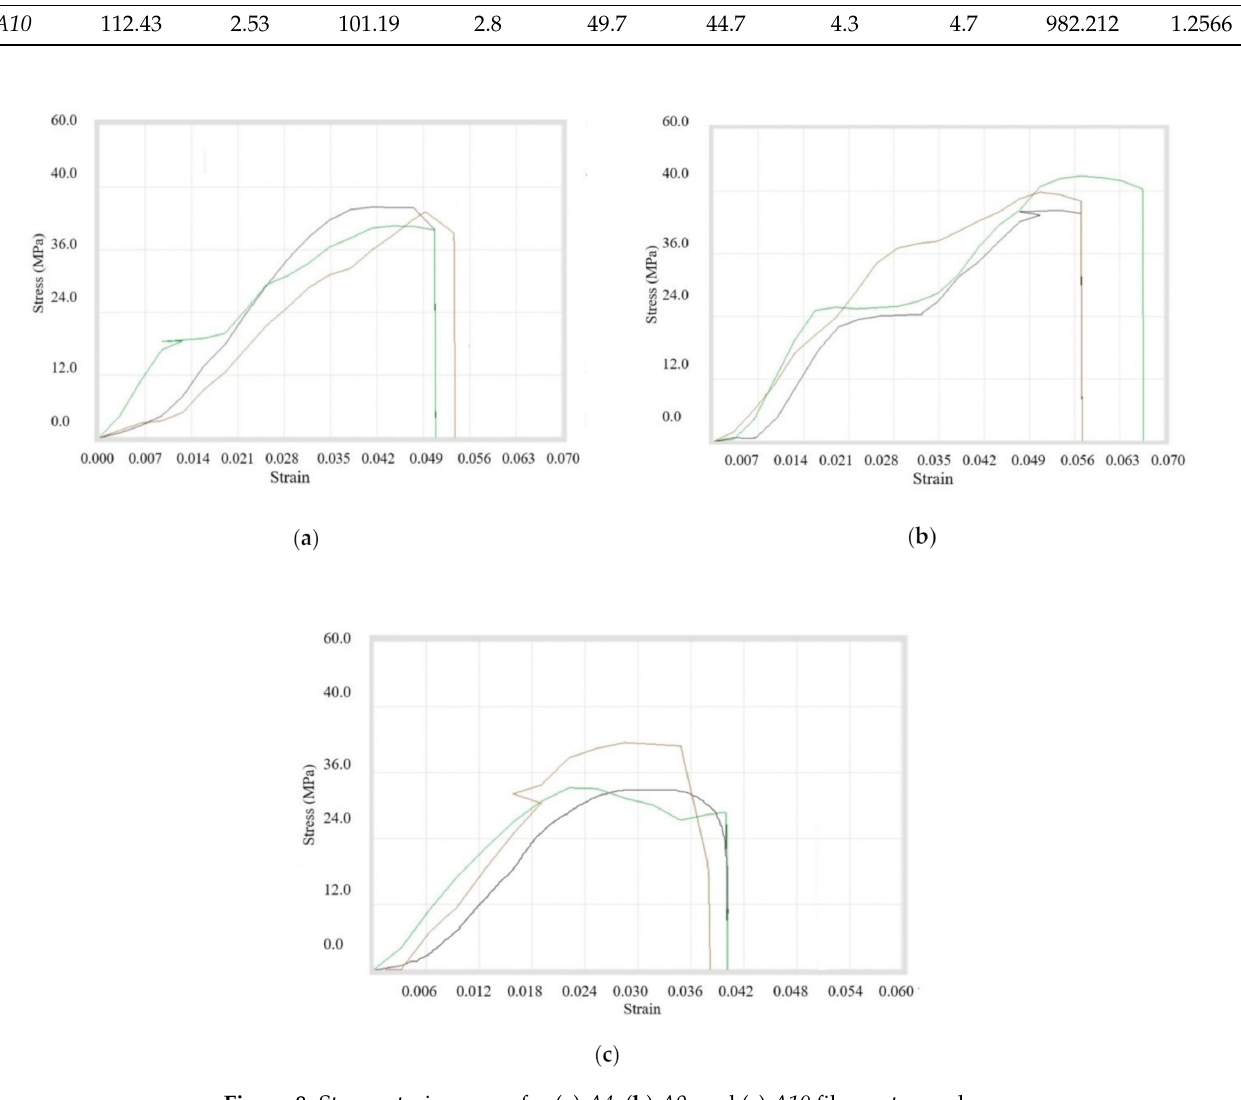
Figure 8. Stress–strain curves for ( a ) A4 , ( b ) A9 , and ( c ) A10 filament samples. Secondly, the tensile testing was done for the compositions B4, B9, B10, B7 , and B8 , which were prepared using 200 mesh copper particles. It was found that the maximum values of tensile properties were obtained for the composition of 8% copper and 92% ABS. The maximum value of percentage elongation at break was reached during the composition of 10% copper, while the break elongation was maximum for 1% reinforcement. It was concluded that the ultimate tensile strength was decreasing continuously while increasing the percentage of copper particles with ABS, but it was maximum at 8%